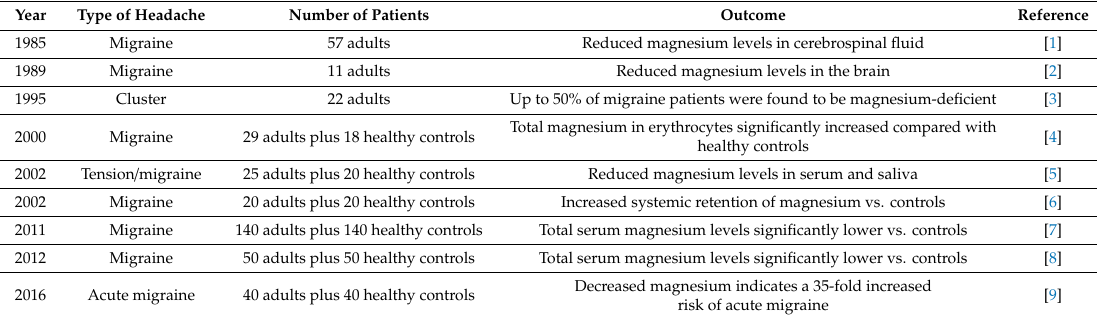
Table 2. Studies investigating the relationship between magnesium levels and